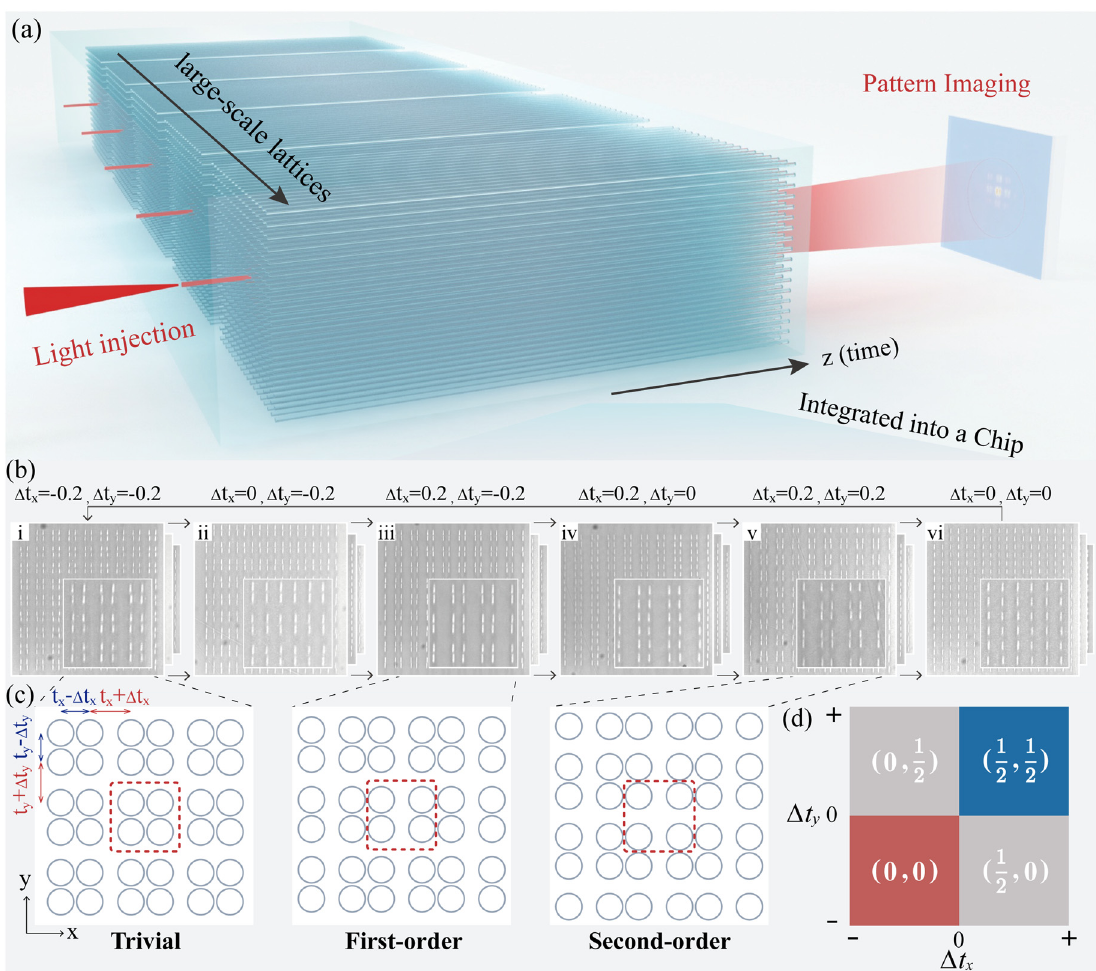
Figure 1: Schematic of observing topological phase transition in highly integrated lattices. (a) The photons are injected into the entrance waveguide in the central unit cell. All the large-scale topologically-differential lattices, possessing different topological phases, are integrated in a chip with the well-locked environment. (b) The micro crosssection of the topologically-differential lattice with gradually varying distortion. (c) Trivial phase, FOTI phase and SOTI phase are supported in the = 0 . 3 and Δ t is smoothly modulated from − 0 . 2 to 0.2. The unit of the coupling constants is fabrication samples. The parameter t x , y x , y [ mm − 1 ] . (d) Topological phase diagram characterized by the wave polarization. Trivial phase, FOTI phase and SOTI phase are marked in red, gray and blue regions, respectively. , 0), the energy band Q = (0 , 0), and the FOTI phase, Q = ( 1 2